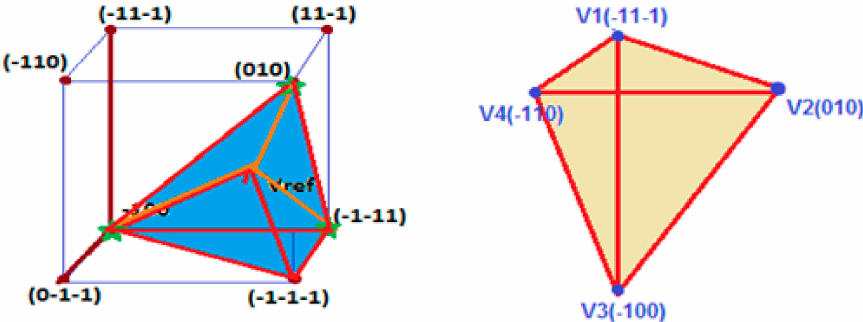
Figure 9. Switching vector selection for Prisim1 located in subcube.